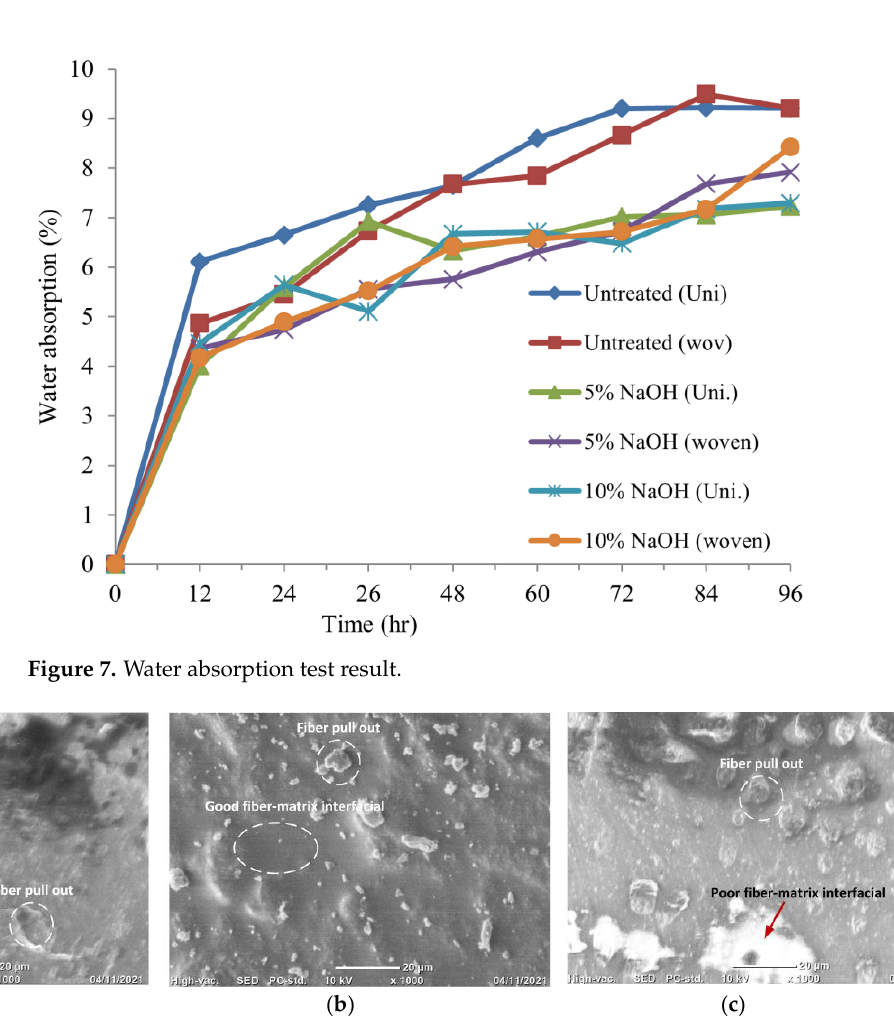
Figure 8. SEM image of woven enset/sisal hybrid composite ( a ) untreated; ( b ) 5% NaOH-treated; and ( c ) 10% NaOH-treated.